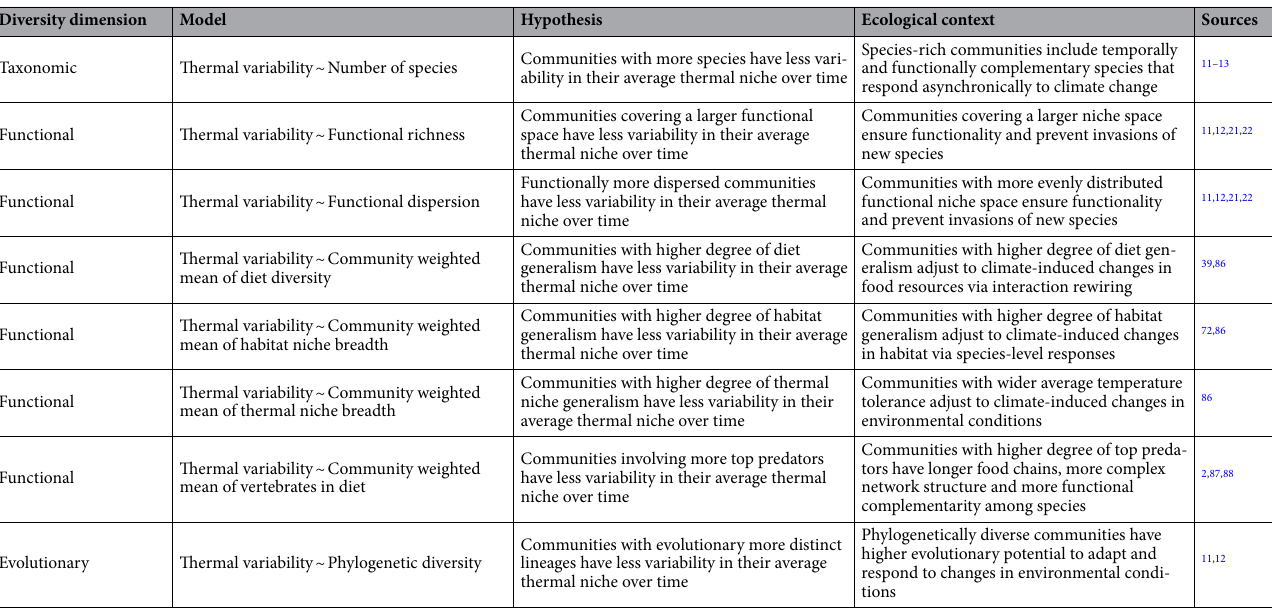
Table 1. List of hypotheses for the diversity-thermal variability relationship. The expected effect of each diversity measure on thermal variability is specified in column ‘Hypothesis’. For more details on the model structures, see